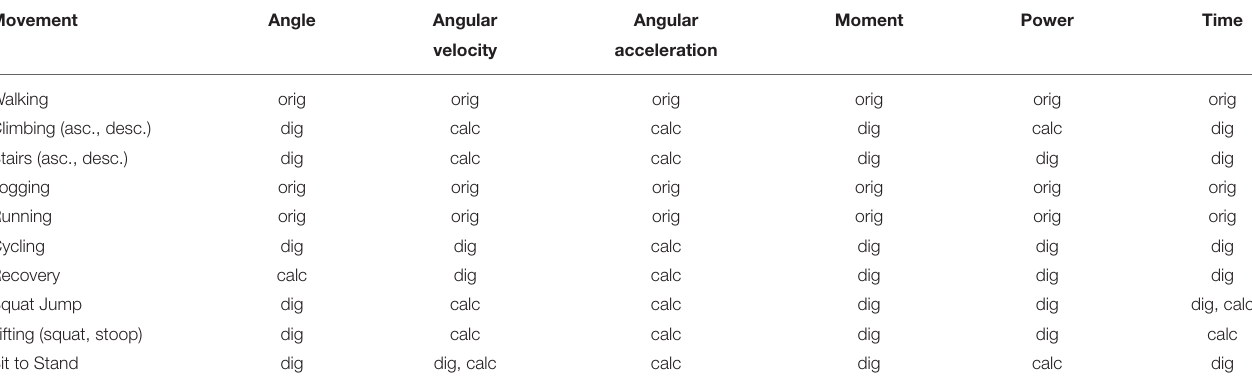
TABLE 3 | Availability of biomechanical data for the selected movement tasks. Movement Angle Angular Angular